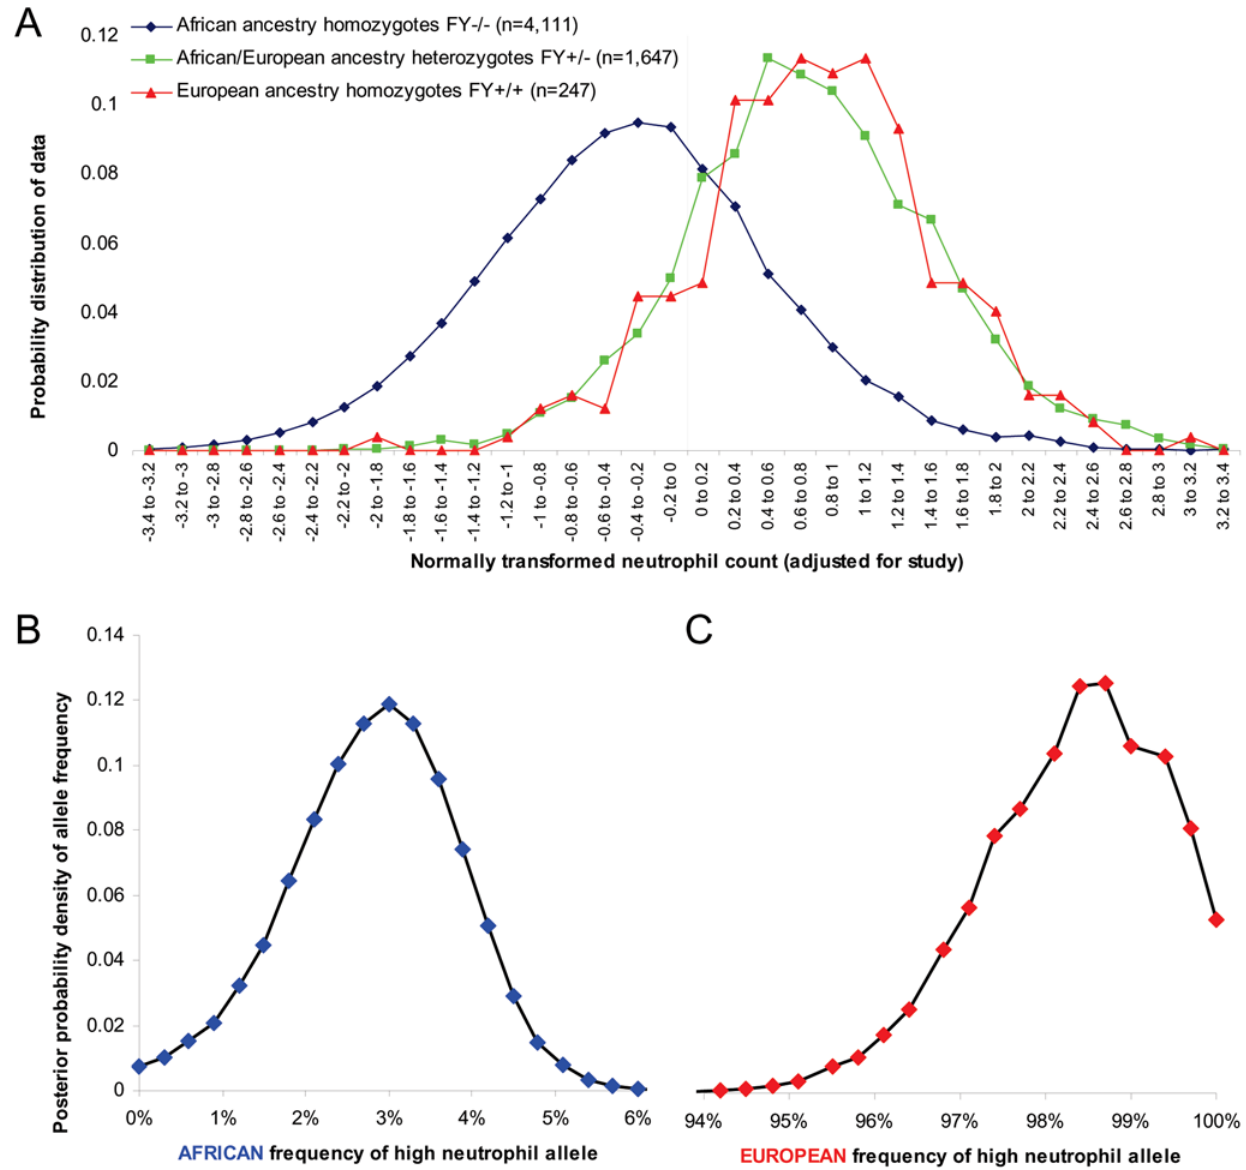
Figure 1. Relationship between ancestry and the distribution of neutrophil count. (A) Distribution of normally transformed absolute neutrophil count for the three classes of genotype at rs2814778. Individuals who are homozygous for the null allele have distinctly lower neutrophil count ( 2 0.35 6 0.89 standard deviations compared with the mean) than individuals who are carriers for the functional allele (0.76 6 0.89). We were able to place constraints on the frequency of the high neutrophil count allele in (B) West Africans, and (C) European Americans by assuming that the observed distributions of neutrophil count for each ancestry class (which we marked in practice by the genotype at rs2814778) are a mixture of distributions specified by the underlying allele frequency. The results indicate a 99% probability that the frequency is , 4.9% in Africans and also a 99% probability that the frequency is . 95.2% in Europeans.